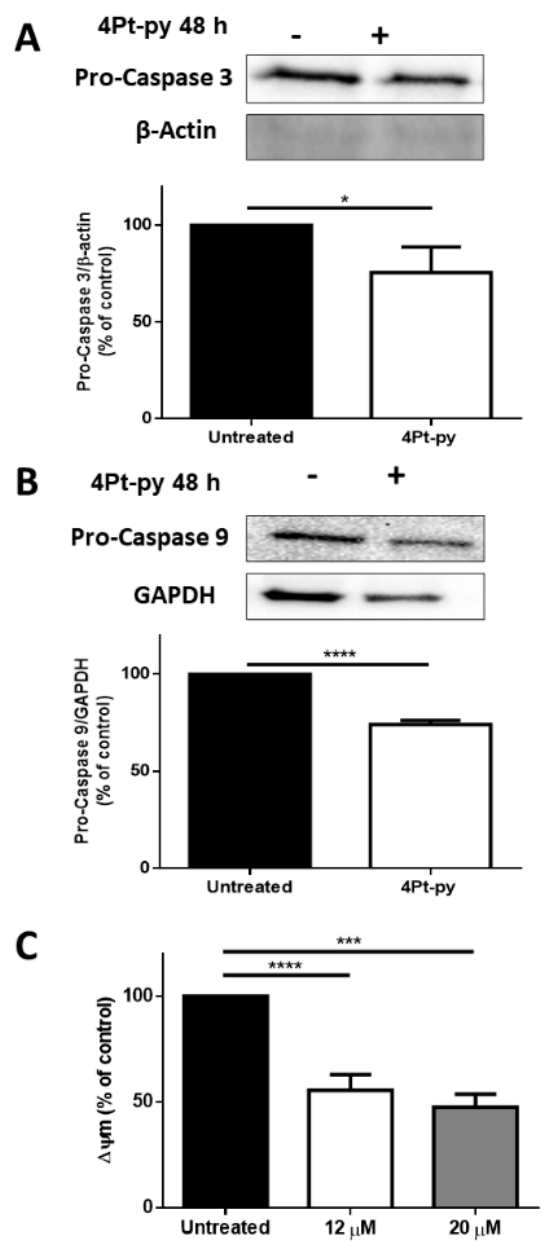
Figure 9. Analysis of 4Pt-py-induced cell death. A431 cells were incubated with 12 µ M of 4Pt-py for 48 h. ( A , B ) Analysis by Western blotting of pro-caspase-3 and -9. B-actin or GAPDH was used as the loading control. The densitometric analysis is reported below each Western blotting. ( C ) Changes in mitochondrial membrane potential ( ∆ ψ m) after 48 h incubation with an increasing amount of 4Pt-py . The fluorescence intensity of the probe, related to ∆ ψ m, is reported as a percentage of the control (%). Data shown are the means ± SD of three independent experiments; * indicates p < 0.05, *** indicates p < 0.005, and **** indicates p < 0.001 with respect to untreated cells.